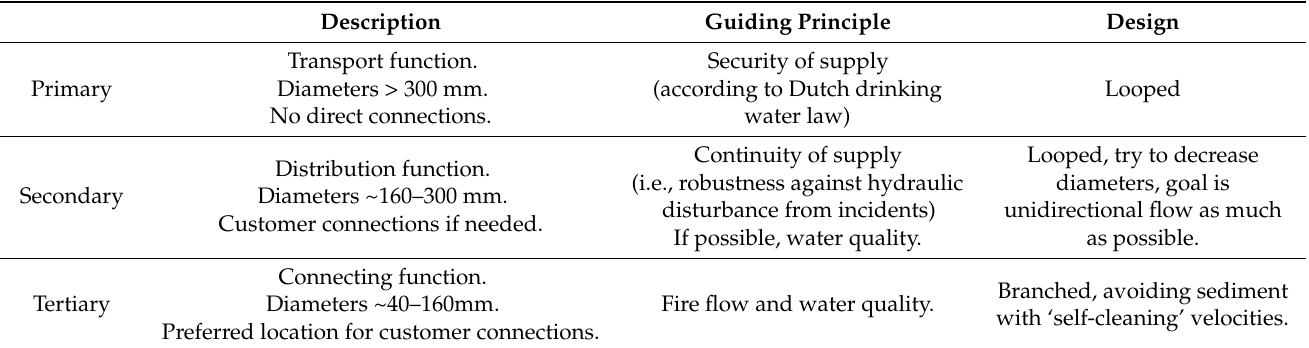
Table 1. Summary of the best-practice structured design of a WDN in the Netherlands, considering a primary, secondary and tertiary part in a